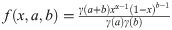
CDFs and best fits of MAE data.Data in (a) is best described by an exponential distribution function with a probability density function of f(x) = exp(−x), for x >= 0. Data in (b) and (c) is best described by a beta distribution function with a probability density function of f(x,a,b)=γ(a+b)xα−1(1−x)b−1γ(a)γ(b), for 0 < x < 1, a > 0, b > 0. Data in (d) and (e) is best described by a Weibull max distribution function with a probability density function of f(x, c) = c(−x)c−1exp(−(−x)c), for x < 0, c > 0. Table 3 shows the first moments of subfigures. For supporting information, see S4 and S5 Tables.